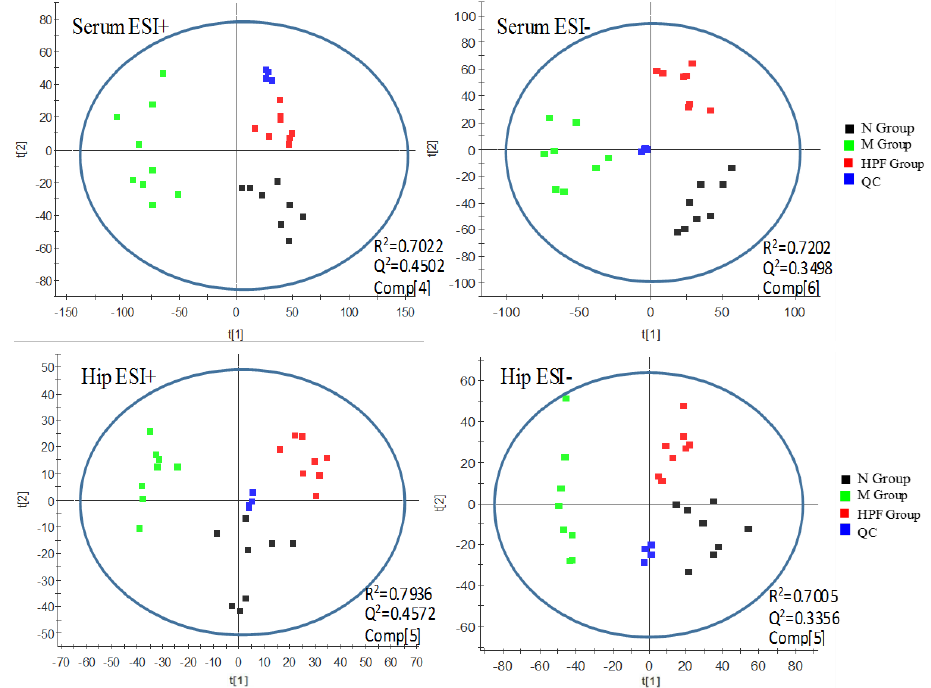
Figure 5. PCA score plots of serum and hippocampus metabolic profiling of the N, M, HPF groups.